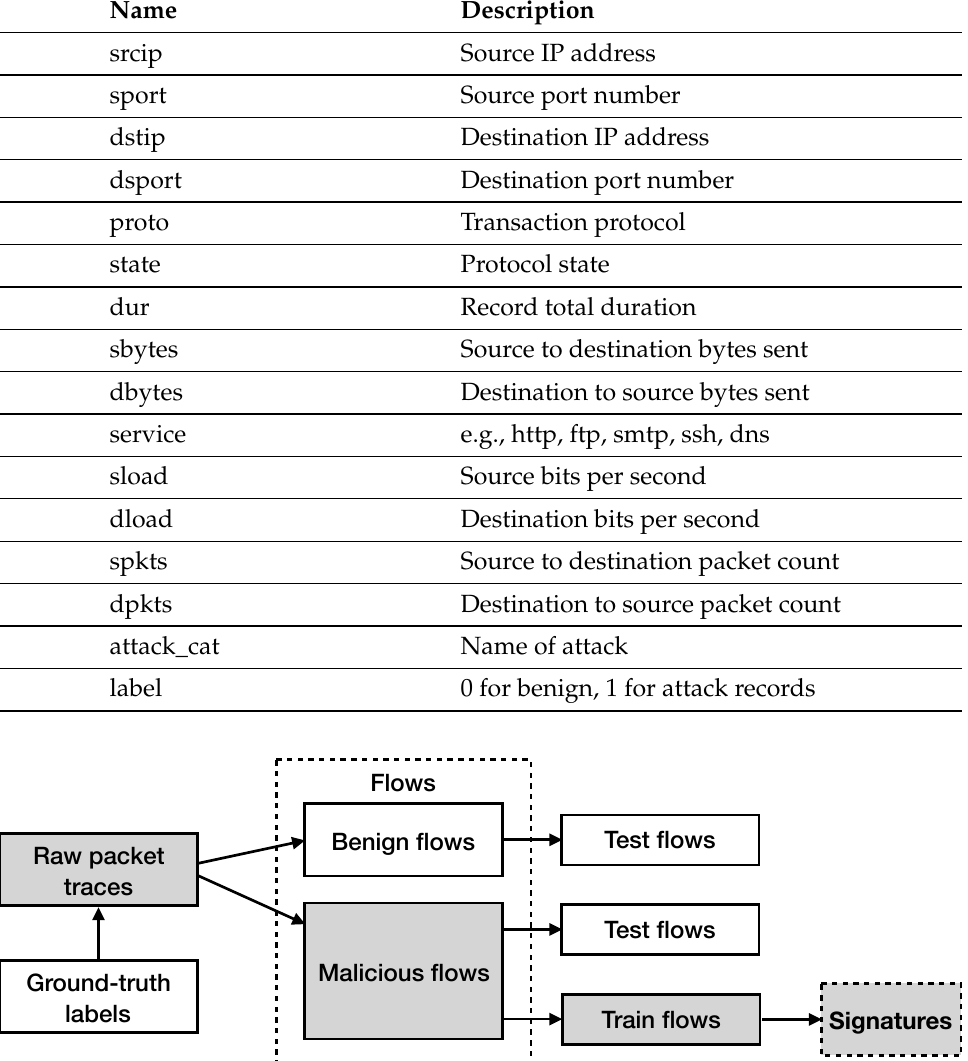
Figure 4. Overview of the signature generation procedure. The traffic traces are arranged into network flows. Each flow is marked as malicious or benign, according to the ground-truth labels. Malicious flows are further divided into two sets; the first set is used for testing and the second set is used for signature